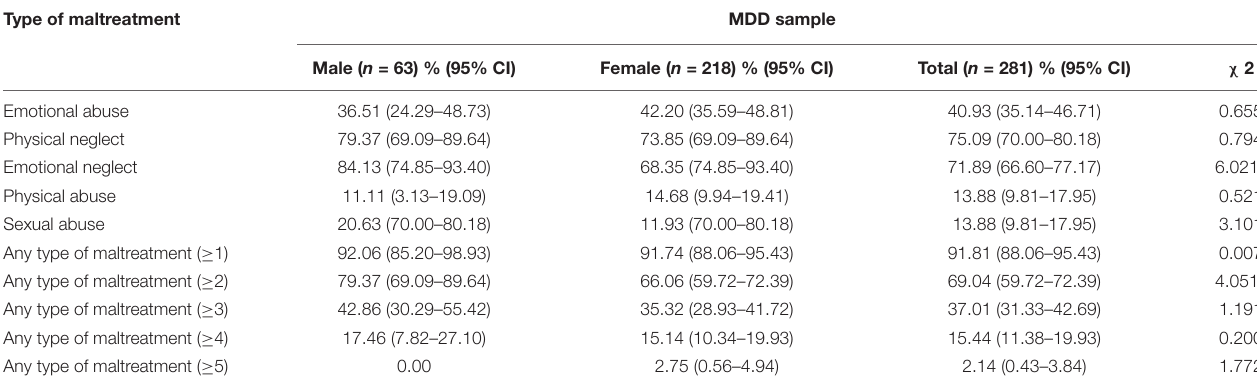
TABLE 4 | Prevalence of CTQ-SF in MDD sample.